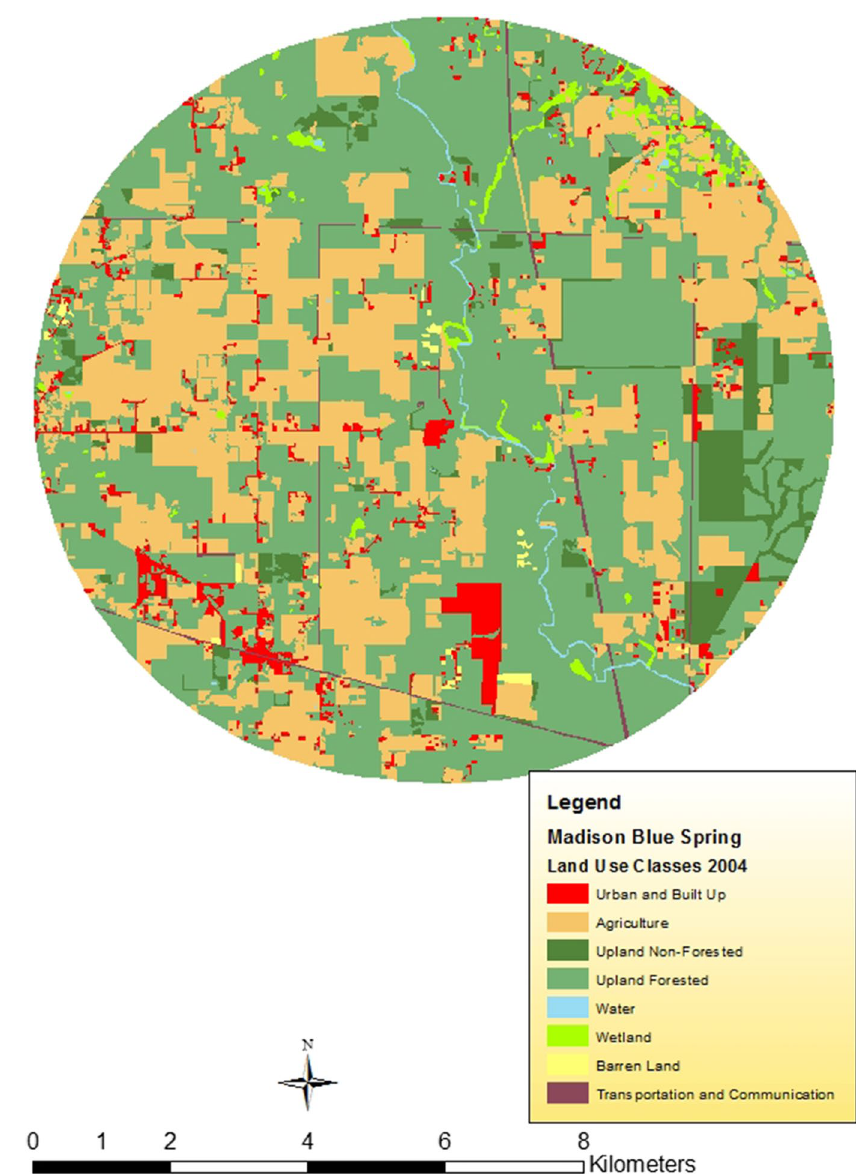
Fig. 4 Land use within 10 km of Madison Blue cave passage centerline